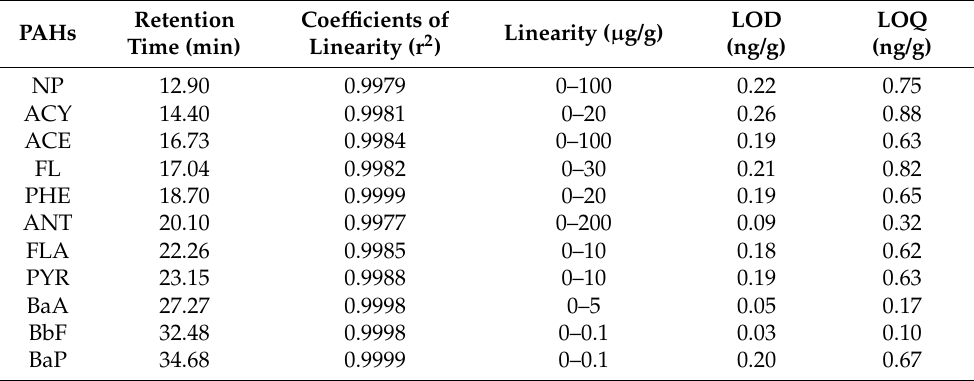
Table 3. Parameters of method validation (retention time, coefficients of linearity (r 2 ), linearity, limit of detection (LOD) and limit of quantification (LOQ) for the HPLC-FL method). Retention PAHs Time